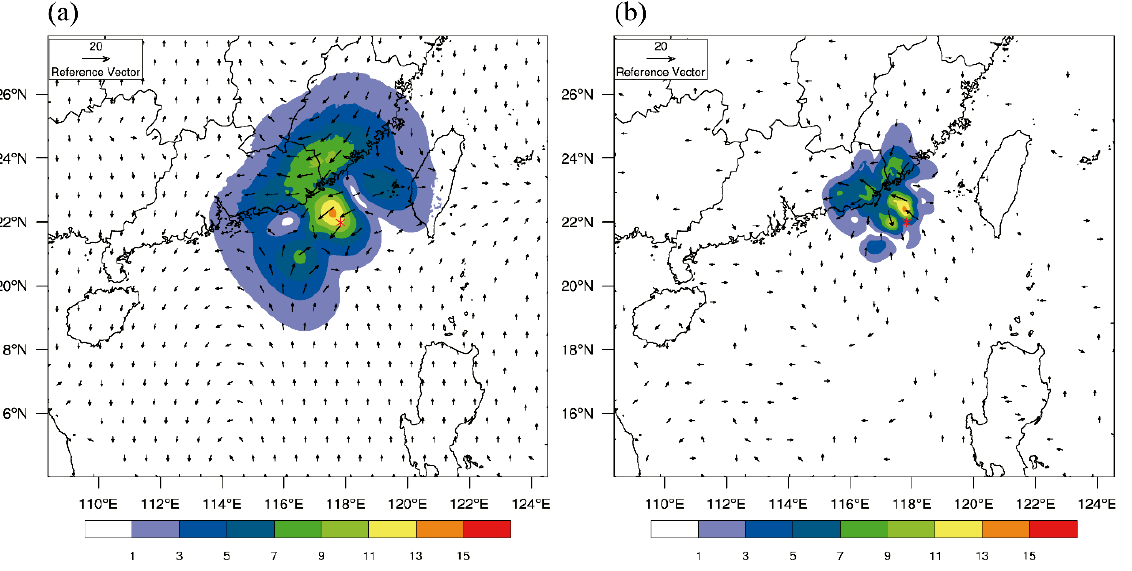
Figure 6. The analysis increments of the wind speed (shaded, unit: m s − 1 ) and wind vector